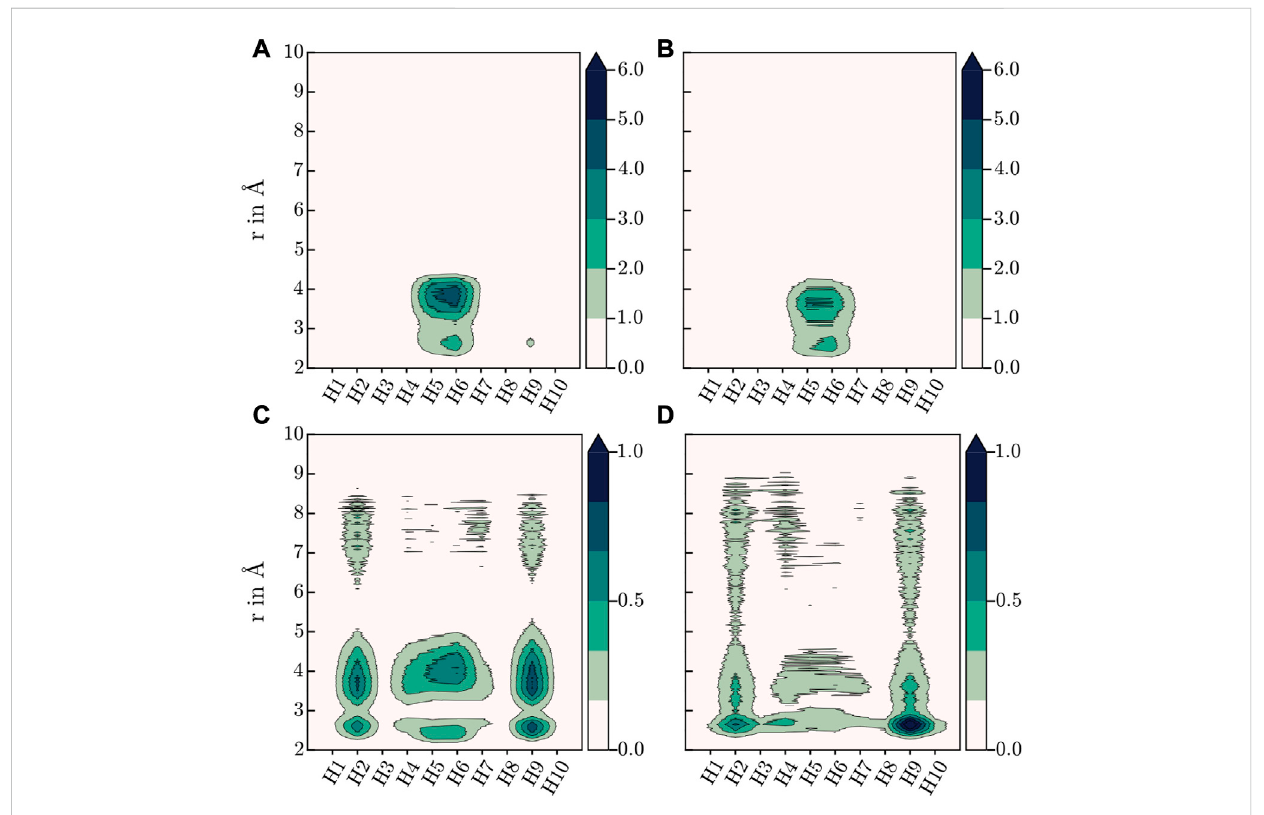
FIGURE 6 Contour plots ofH-contributions to thetotal MDDF at273.15K, (A) HEX-COF1 with8CO 2 /pore, (B) HEX-COF1with 2CO 2 /pore, (C) 3D-HNU5with 16 CO 2 , (D) 3D-HNU5 with 4 CO 2 (see Figure 1A for labelling of the azine linker hydrogens).